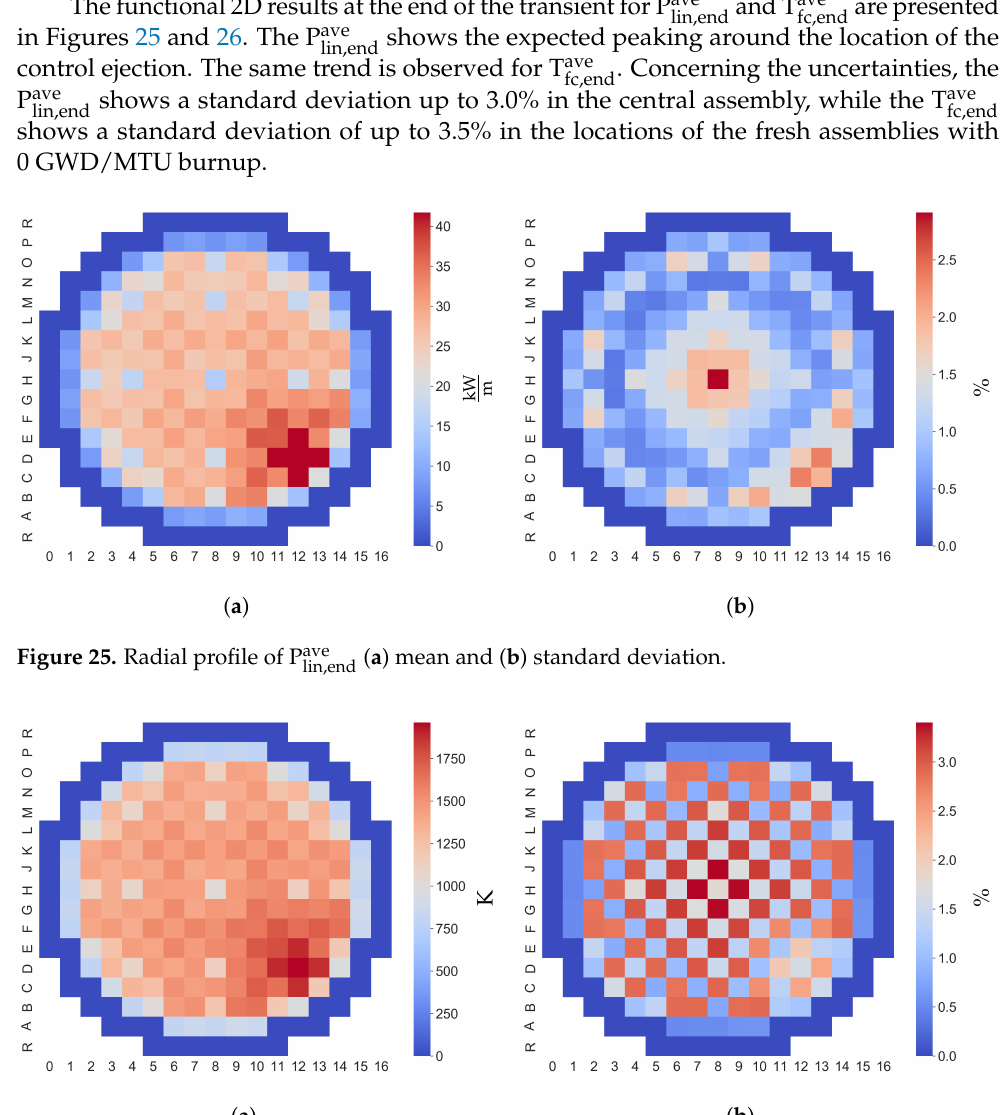
( a ) mean and ( b ) standard fc,end